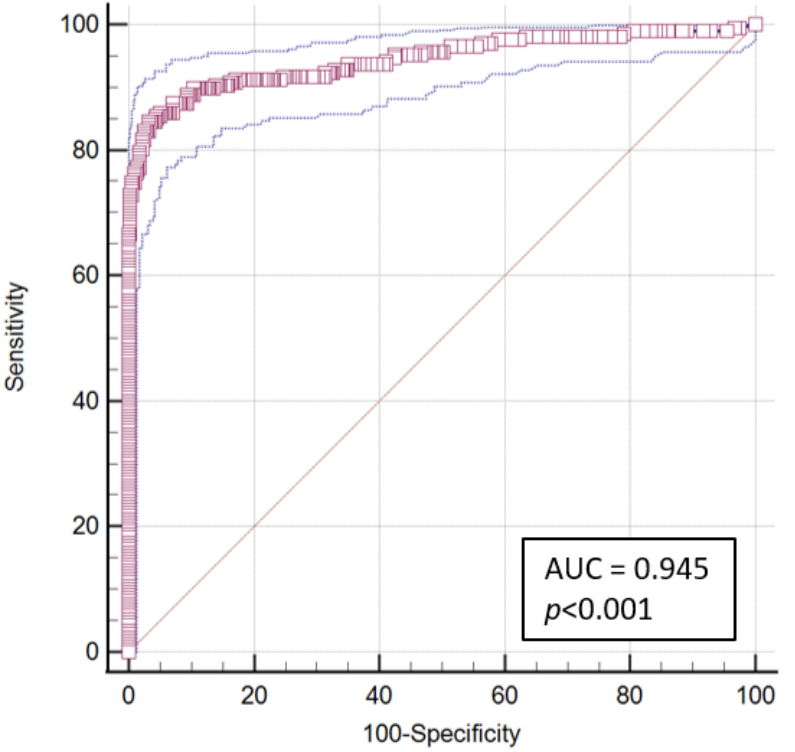
Figure 3. ROC curve analysis performed for FIA to detect COVID-19 NAAT confirmed cases ( n = 603, as in yellow box of Figure 1).